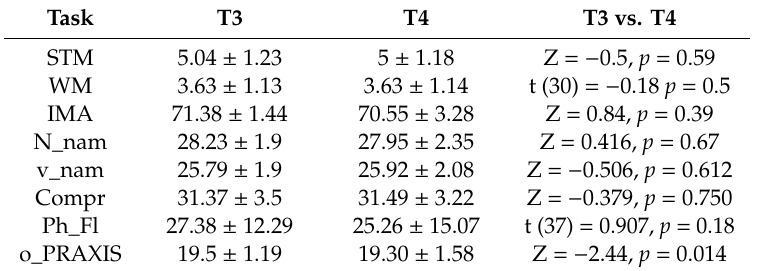
Table 3. Shapiro–Wilk test, using a = 0.05, on the normality distribution of the patients’ level of performance. Task Pre-Surgery Post-Surgery WM p = 0.28 p = 0.74 Ph_Fl p = 0.19 p = 0.51 Compr p < 0.001 p < 0.001 o_PRAXIS p < 0.001 p < 0.001 STM p = 0.01 p = 0.2 IMA p < 0.001 p < 0.001 N_nam p < 0.001 p < 0.001 v_nam p < 0.001 p < 0.01